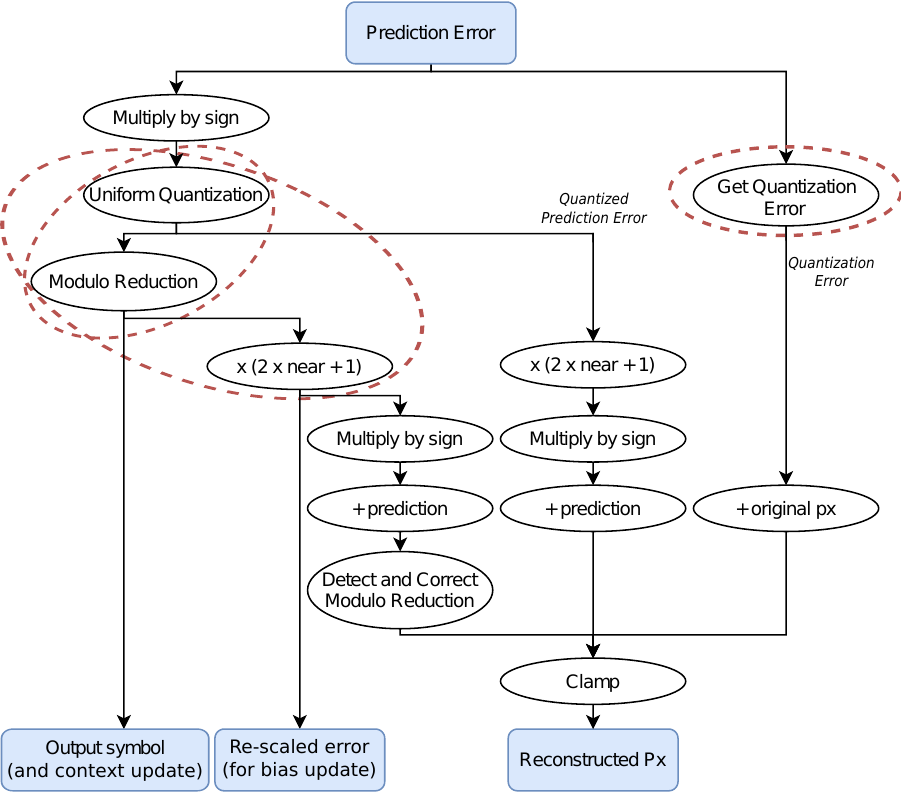
Figure 4. Quantization processes. The operations performed by tables are indicated with red